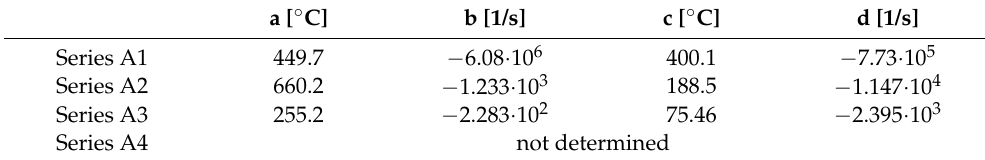
Table A1. Fitting Parameters describing the cooling profile during thermal shock treatment. a [°C] b [1/s] c [°C]